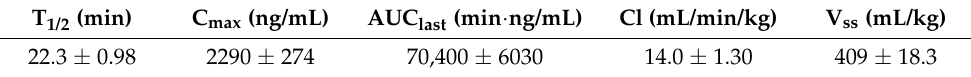
Figure 4. Time to concentration profile of α -amanitin in rats after IV administration at 1 mg/kg. Table 6. PK parameters of α -amanitin in rats after IV administration at 1 mg/kg.